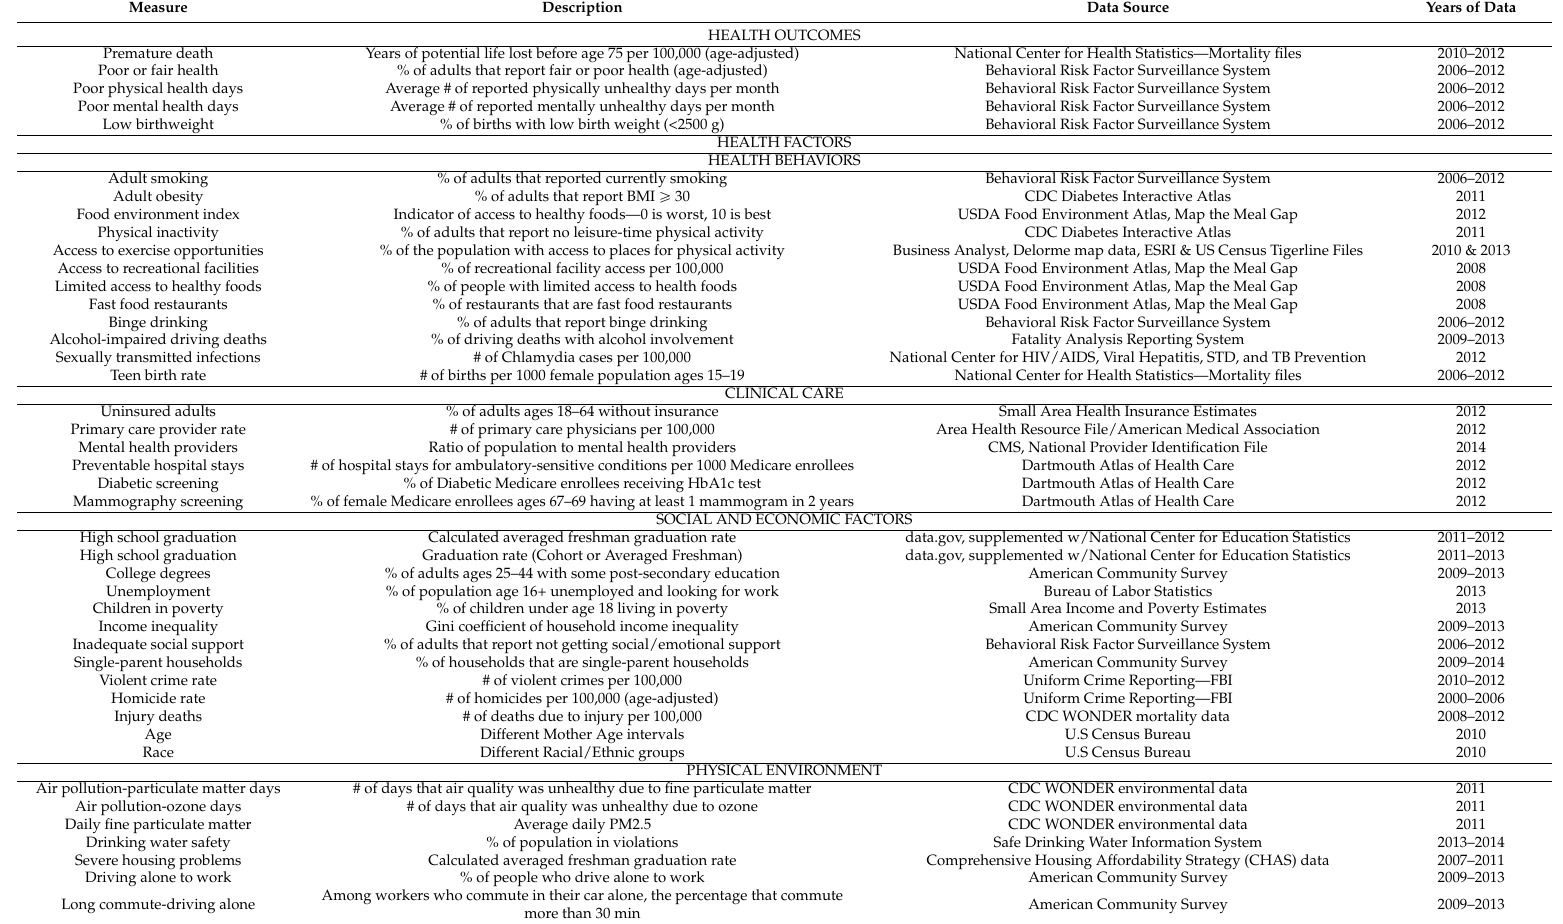
Table 1. A list of variables used in the exploratory regression